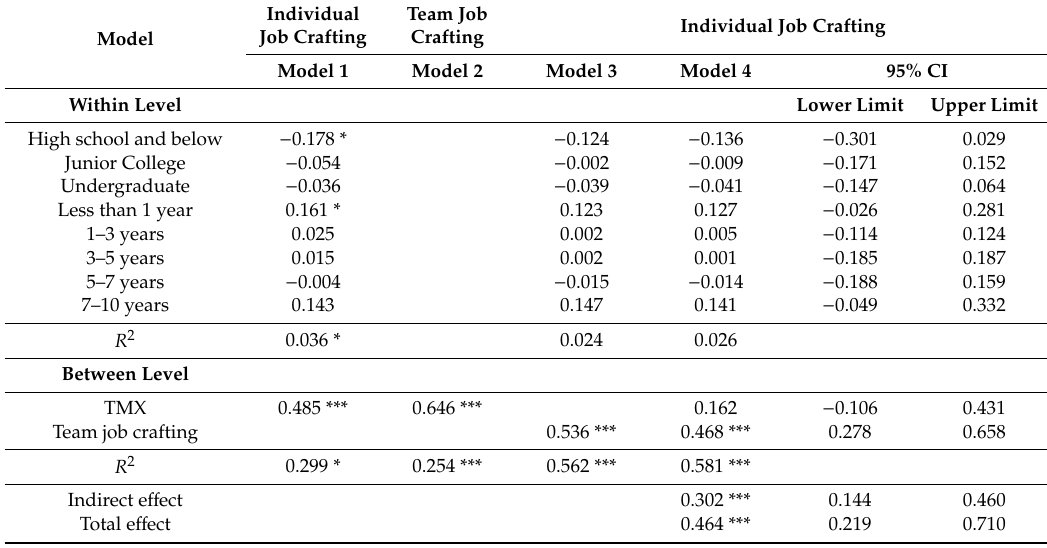
Table 9. The relationships among team-member exchange behaviors, and individual and team job crafting